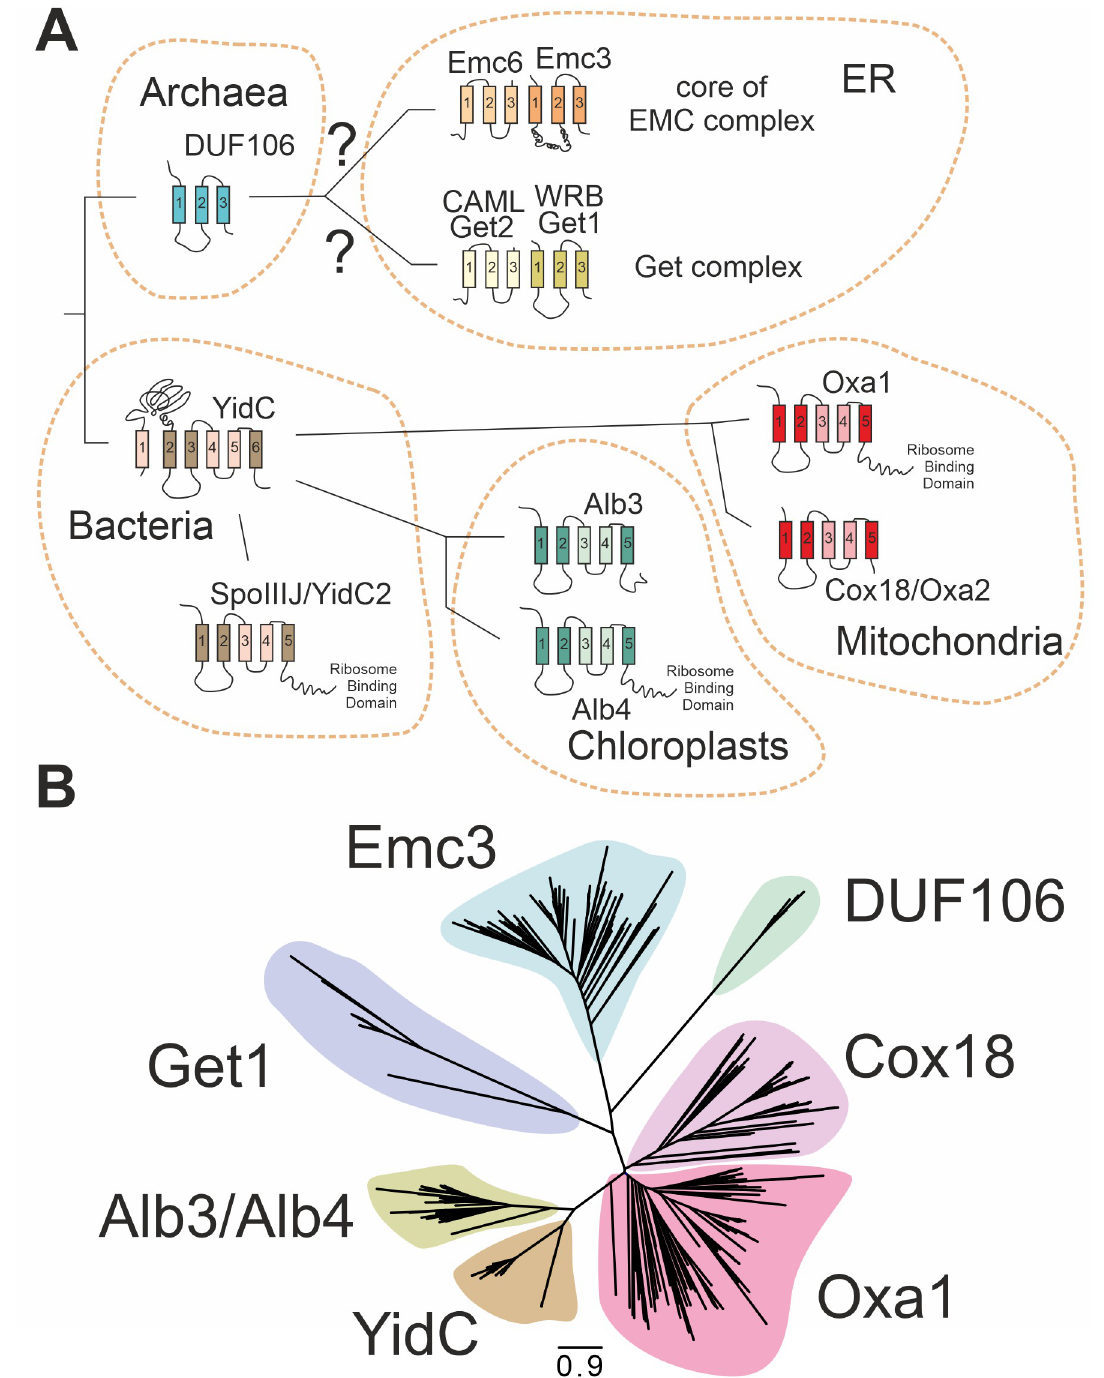
Fig 1. The members of the Oxa1 superfamily are structurally similar; however, their phylogenetic relationship is unclear. (A) All shown proteins serve as membrane insertases. Whereas the representatives of bacteria, mitochondria, and chloroplasts are monomeric proteins with 5 or 6 transmembrane domains, the insertases of the ER form oligomeric complexes of 2 (Get1/Get2) or multiple (EMC) subunits. Recent studies on the structure of the GET and EMC complexes proposed that Emc3 and Get1 are structurally related to YidC, Oxa1, and Alb3. The transmembrane domains that share structural similarity are indicated in darker color. (B) Blast searches identified 460 homologs of DUF106, Emc3, Get1, Alb3/Alb4, Oxa1, and YidC proteins from different species (see S1 Fig and S1–S3 Data). This tree supports the relatedness of these protein groups and is consistent with the hypothesis that Emc3 is related to